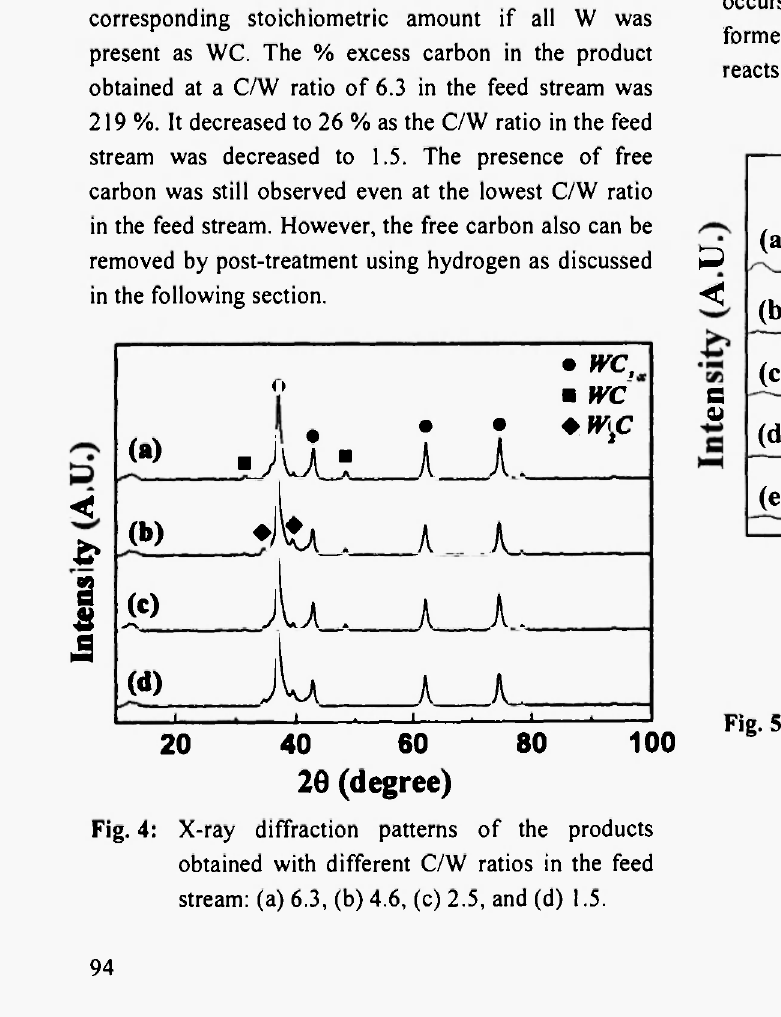
Fig. 4: X-ray diffraction patterns of the products obtained with different C/W ratios in the feed stream: (a) 6.3, (b) 4.6, (c) 2.5, and (d) 1.5.